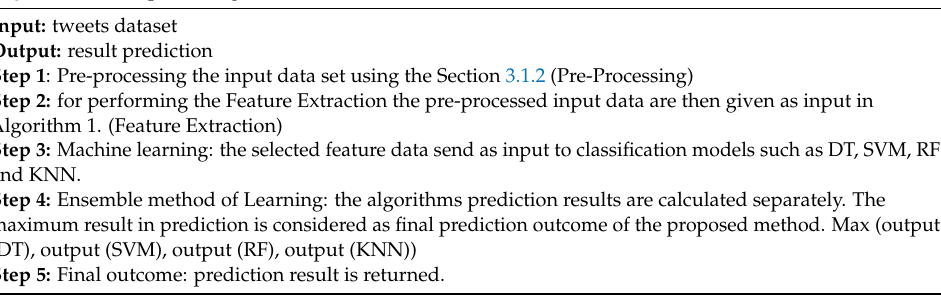
Algorithm 2. (Proposed N-gram with Stacked Auto